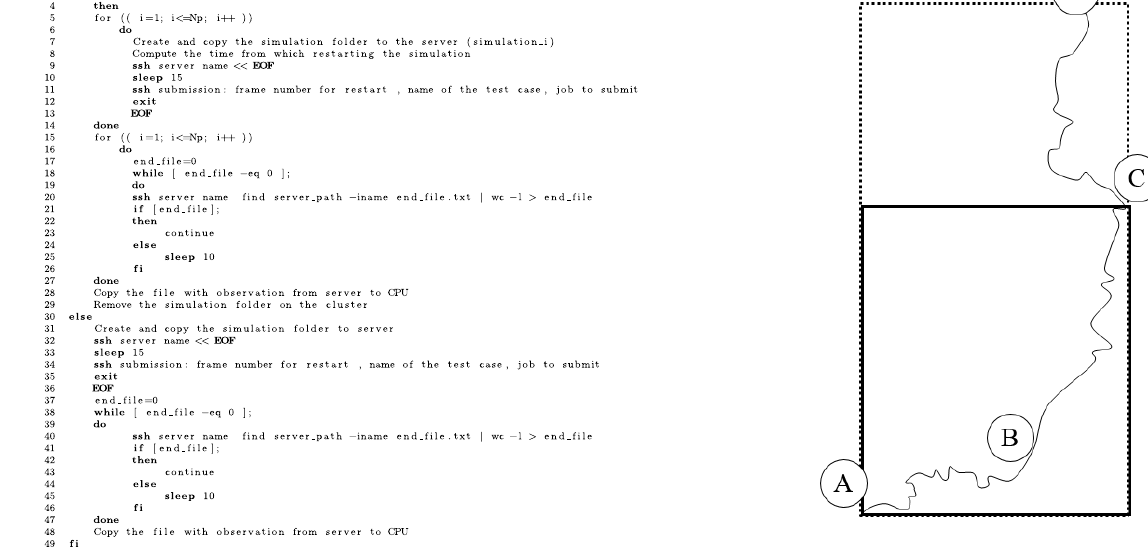
Figure 6. Exemplification of a test case